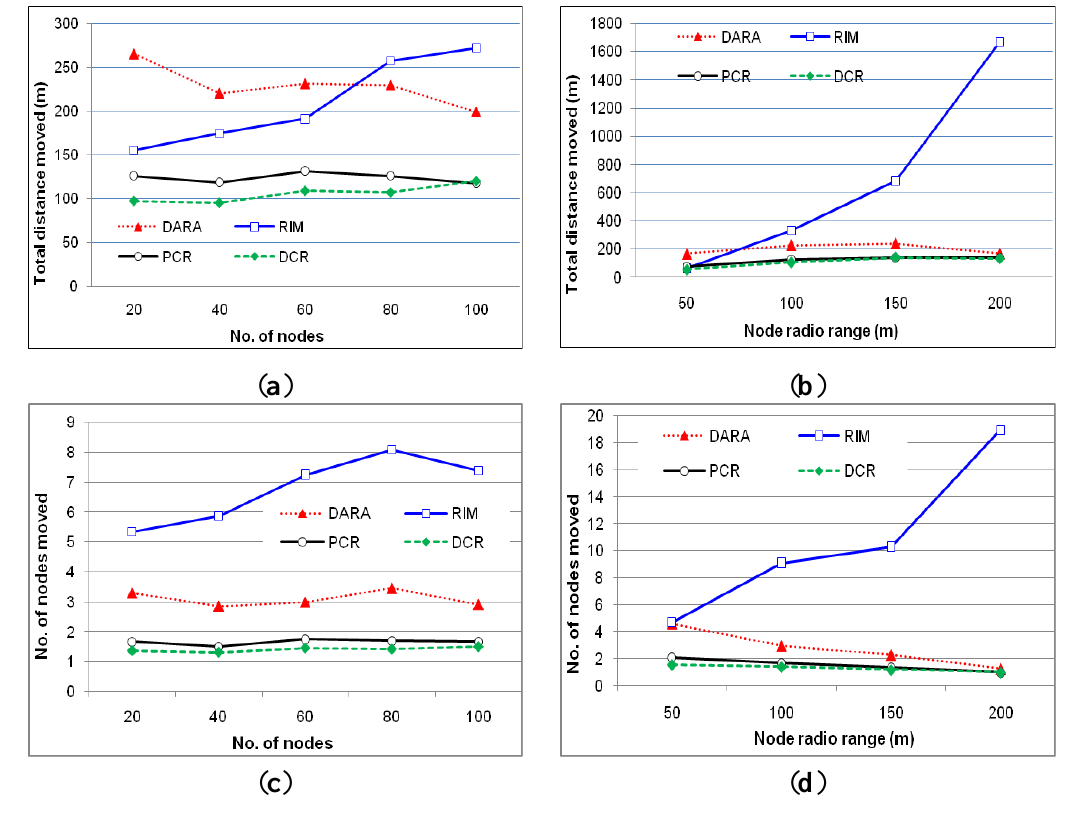
Figure 8. The total movement distance as a function of N in ( a ) and r in ( b ). The effect